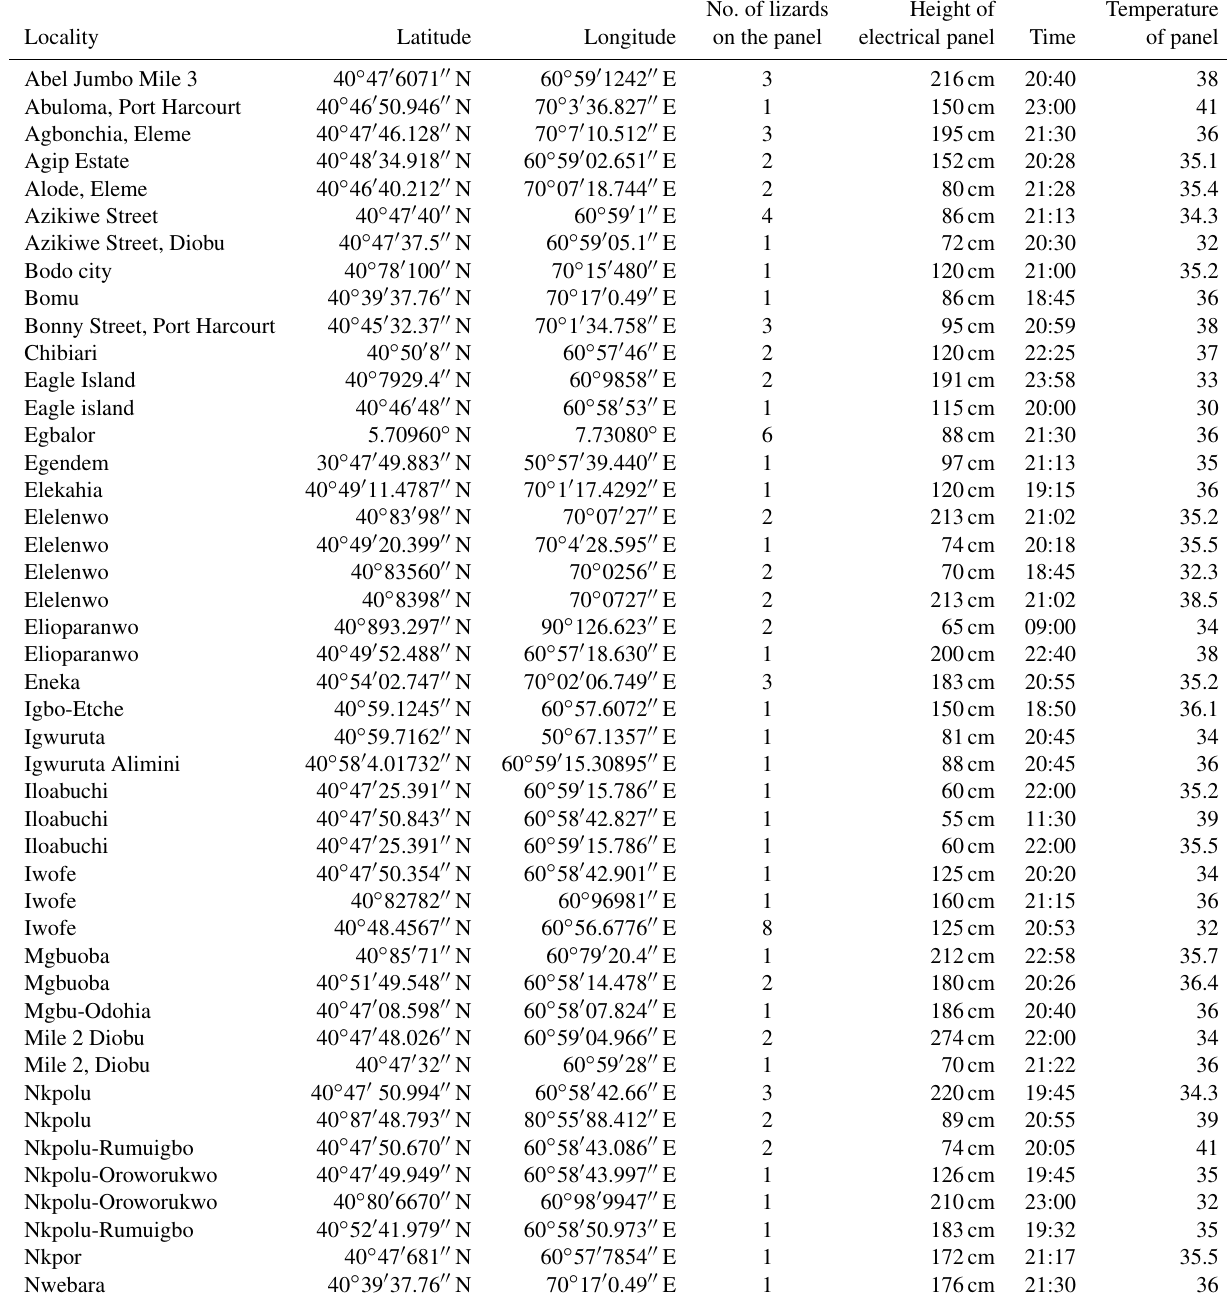
Table A1. Summary of the raw data concerning study areas (and geographic coordinates), number of Agama agama individuals observed on the electric panels, height of the electric panels, time of observation (Lagos standard time) and temperature of the electric panels (in ◦